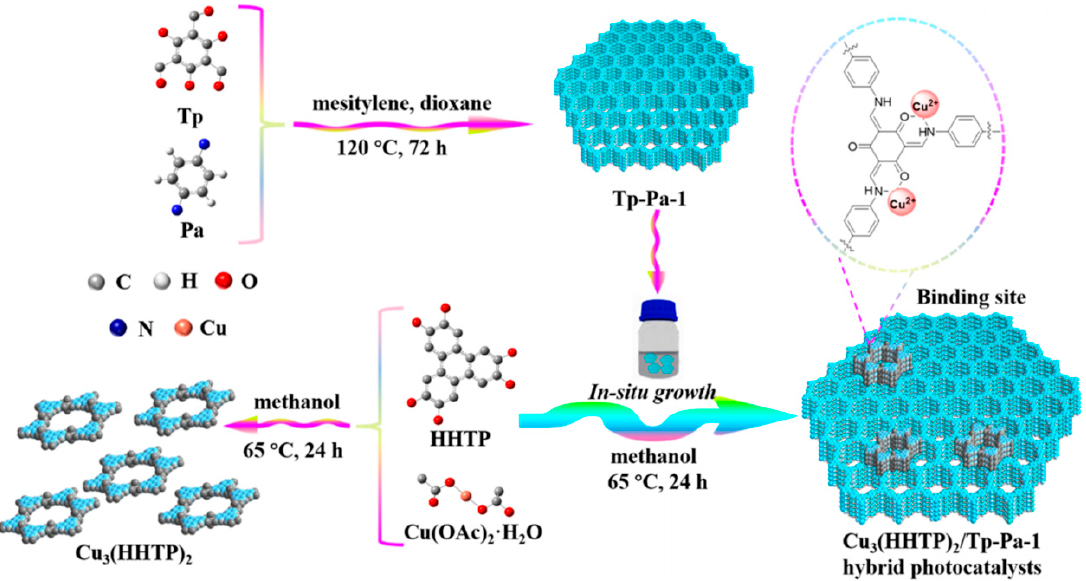
Figure 12. The illustration of synthesis steps of Cu 3 (HHTP) 2 /Tp-Pa-1 hybrid photocatalysts. Repro- duced with permission from Ref. [79].